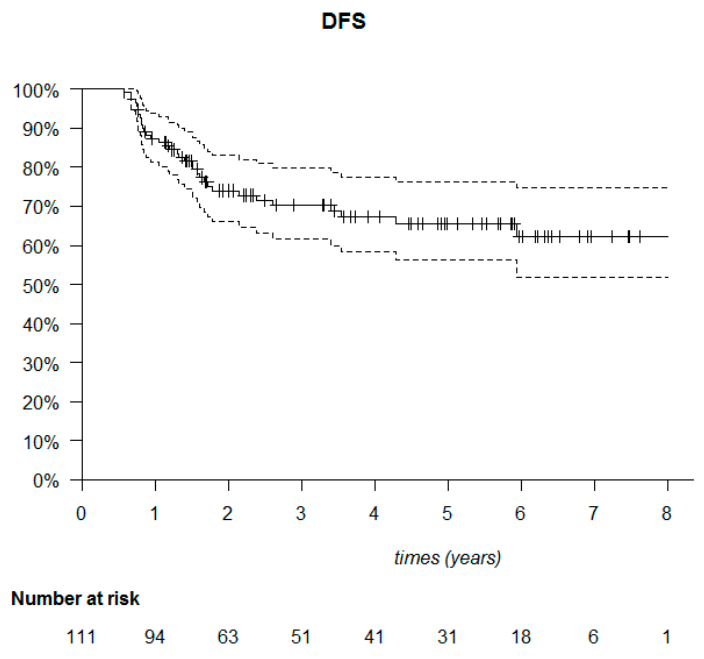
Figure 6. Kaplan–Meier disease-free survival (DFS) of the 111 triple-negative breast cancer pa- tients.